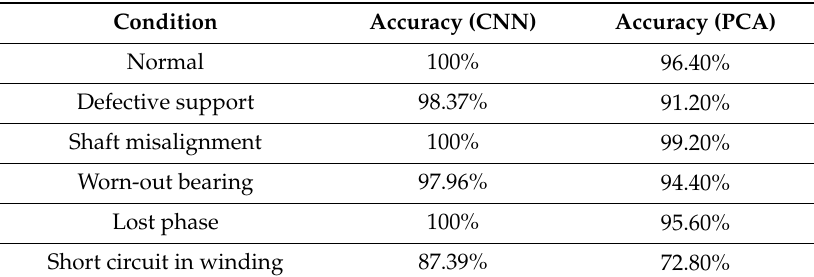
Table 2. Summary of testing results for each class.